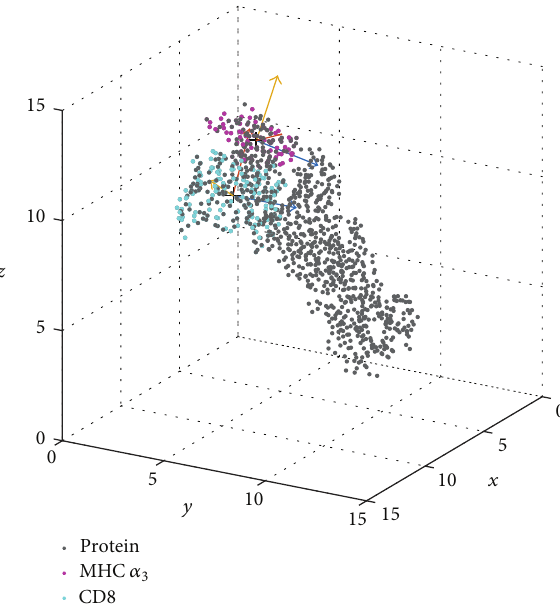
Figure 3: Domains CD8 and MHC 𝛼 3 with local eigenvectors. Domain CD8 is shown in cyan, 𝛼 3 in purple, and the remaining parts of the MHC as well as the TCR (labelled “protein”) in black. Eigenvectors ( k 1 , k 2 , k 3 and w 1 , w 2 , w 3 , resp.) are shown for the first frame of the trajectory and colored ( k 1 , w 1 : blue, k 2 , w 2 : red, k 3 , w 3 : yellow) for each of the